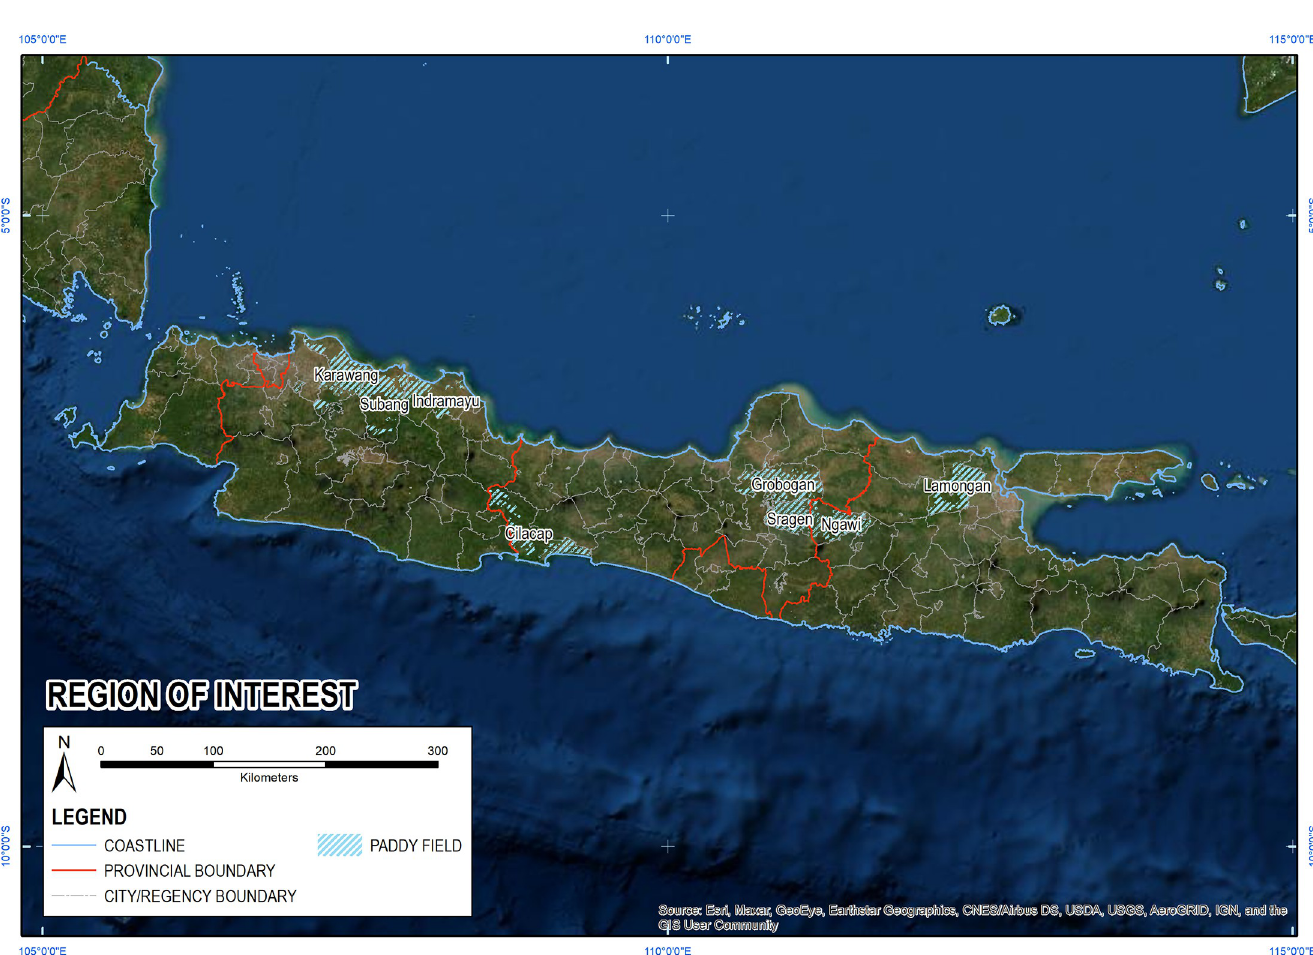
Fig 1. Study area: Java Island and the eight districts of the largest rice producer in Indonesia as the region of interest. The greener areas on the map indicate paddy fields of the region of interest. https://doi.org/10.1371/journal.pone.0260982.g001 satellite products. Table 2 summarizes the datasets, their resolutions, and time covered. The datasets are briefly described below.